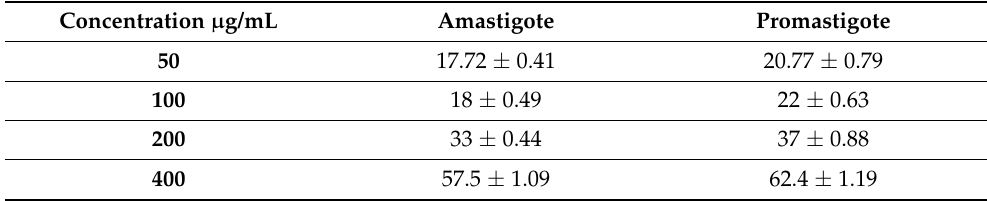
Table 4. Anti-leishmanial potential of FeNPs against amastigote and promastigote.